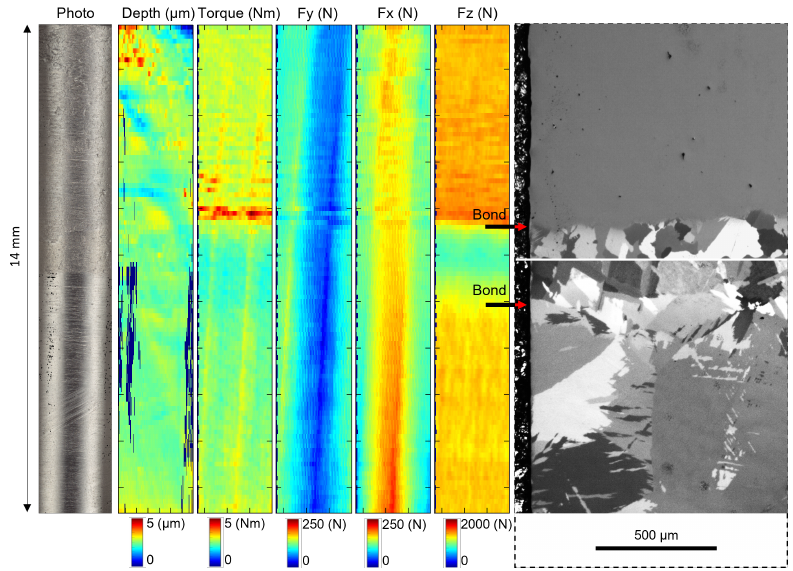
Figure 6. A photograph of the drilled surface, micrographs of the bond interfaces and depth, torque, Fy, Fx and FZ maps for holes drilled at 1845 RPM and F rev = 0.131 mm/rev in the Beta C-Ti-CP-Ti-64 workpiece (three blind sample).